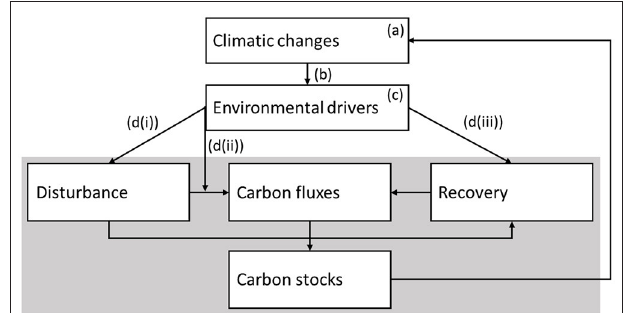
FIGURE 2 | Simplified framework for predicting carbon loss from pulse disturbances under climate change. Predictive understanding relies on a foundational understanding of how the incidence of and recovery from disturbance affects carbon fluxes, and how those carbon flux changes translate to longer-term changes in carbon storage (processes shaded in light gray). Predicting future carbon loss from disturbance under climate change scenarios then requires (a) predictions of climatic changes; (b) mechanistic understanding of how these variables drive (c) key environmental variables that influence incidence of the disturbance in question, and data describing variation in these variables across tundra and boreal biomes; and (d) a mechanistic understanding of how these variables affect (i) disturbance characteristics such as frequency, duration, and spatial distribution; (ii) the severity or intensity of impacts on ecosystem carbon fluxes and (iii) characteristics of recovery such as duration and final